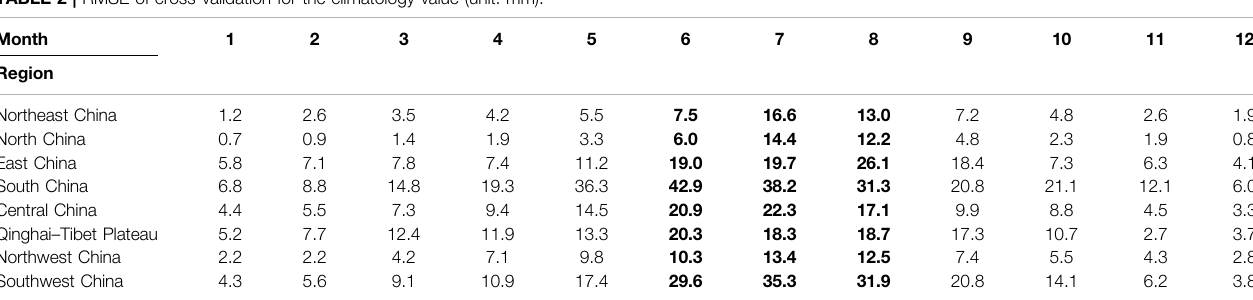
TABLE 2 | RMSE of cross-validation for the climatology value (unit: mm). Month 1 2 3 Region Northeast China 1.2